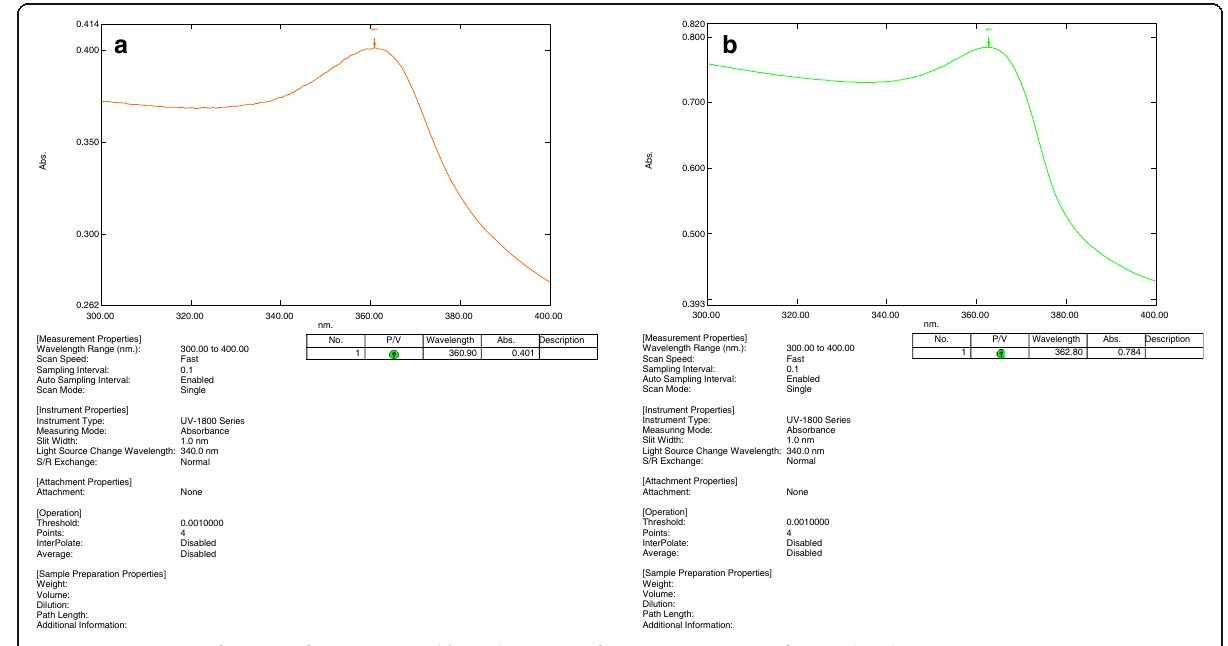
Fig. 4 UV-vis spectra of ZnO NPs from a ZnAc and b ZnCl 2 precursor from aqueous extract of A.